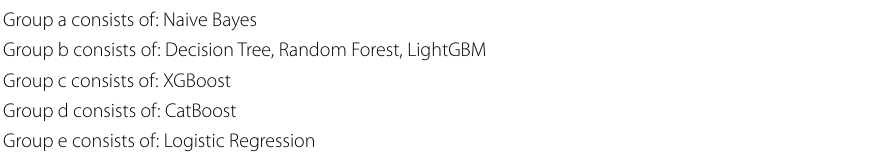
Table 21 HSD groupings of classifiers after 2-factor ANOVA where classifier and sampling ratio are factors with SQL Injection web attacks; groups are by performance in terms of AUC Group a consists of: Naive Bayes